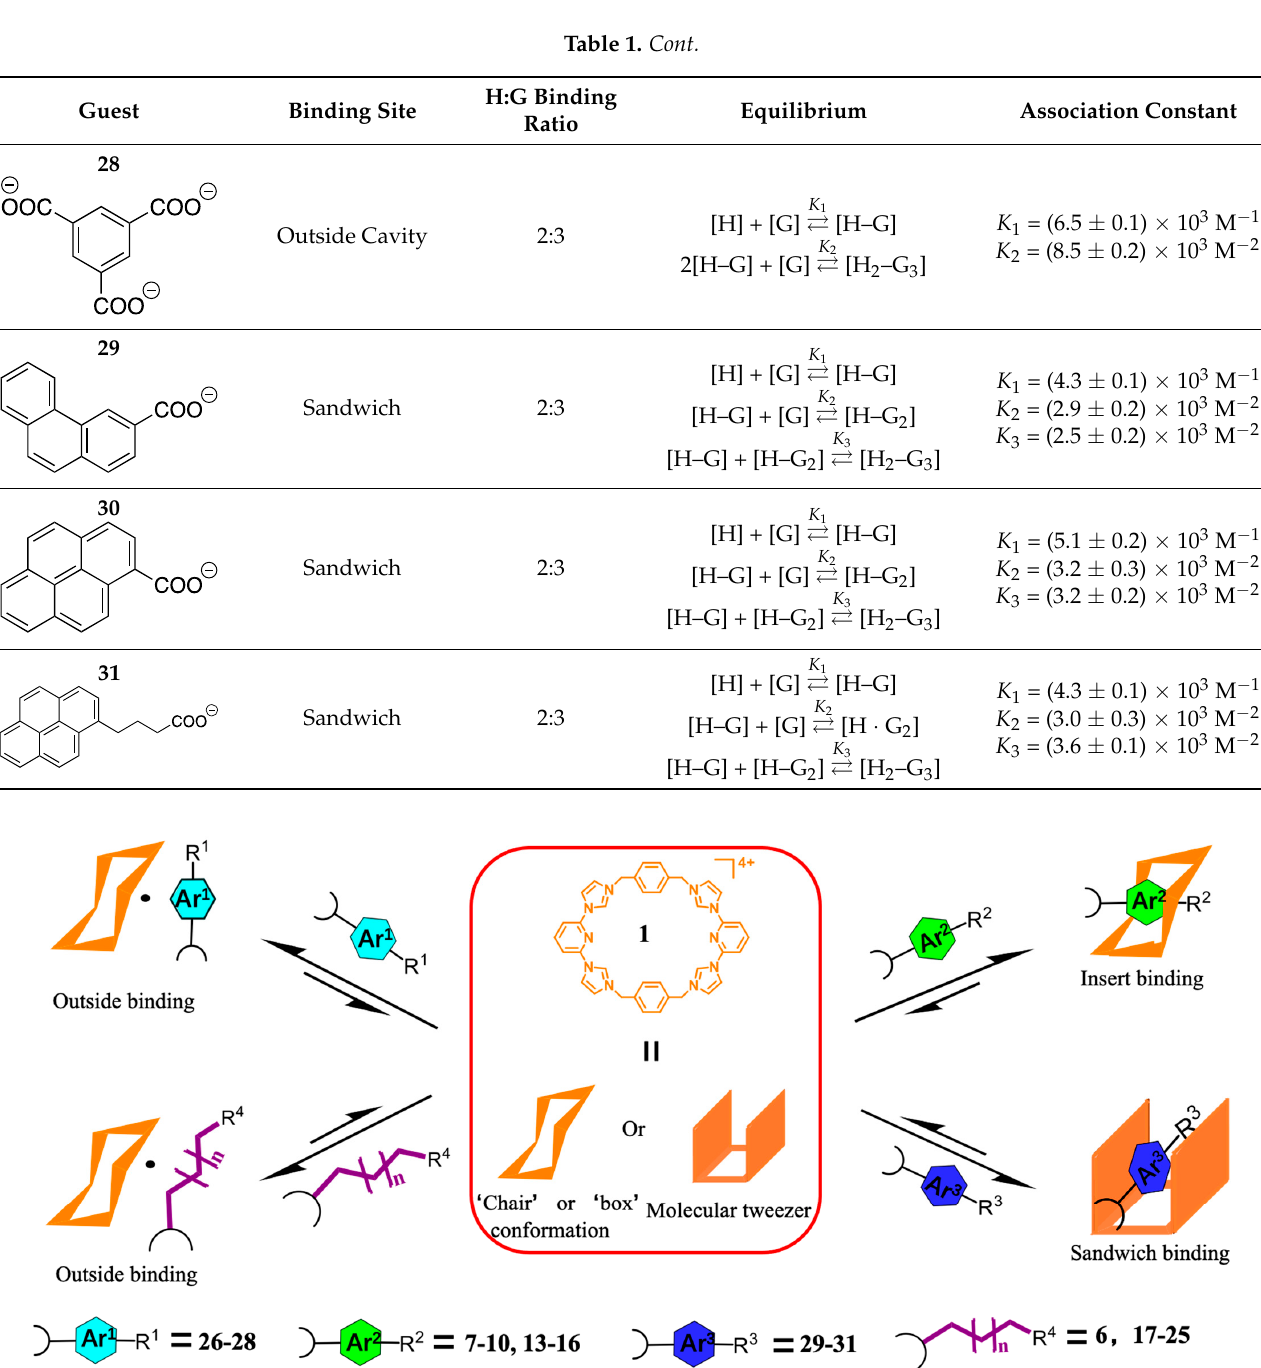
Figure 1. Schematic representations of the limiting binding modes observed when the macrocycle 1 is treated with carboxylate anionic precursors containing different aromatic rings. The associated anion recognition details are summarized in Table 1. Note that the B the location-defining terms of “Outside Cavity”, “Threaded through Cavity”, and “Sandwich” in Table 1 correspond to “Outside binding”, “Insert binding”, and “Sandwich binding” in this figure, respectively. This image is a modification of one that first appeared in ref [50] and is reproduced with permission. Copyright 2015 The Royal Society of Chemistry.